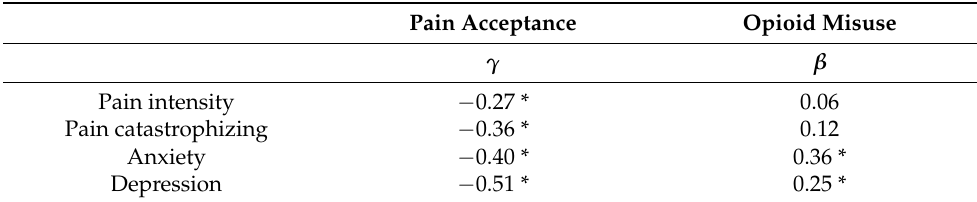
Table 2. Initial model. Standardized gamma and beta coefficients.